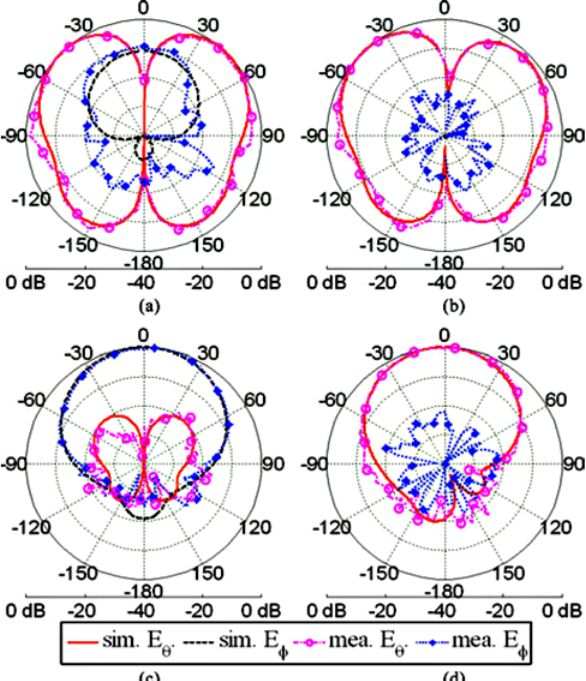
Figure 13. The radiation pattern of the antenna in [105]. Measured and simulated radiation patterns. ( a ) Monopole mode in xz-plane, ( b ) monopole mode in yz-plane, ( c ) patch mode in xz-plane, and ( d ) patch mode in